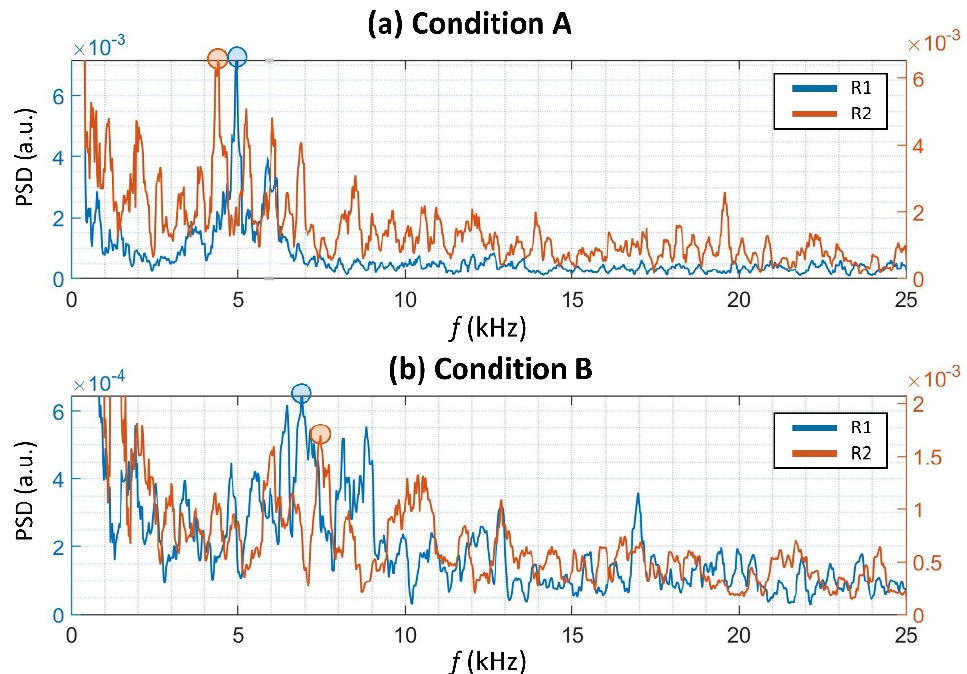
Figure 10. Power spectral density estimate of the LPBF depositions. Replicates in different colours (orange and blue).